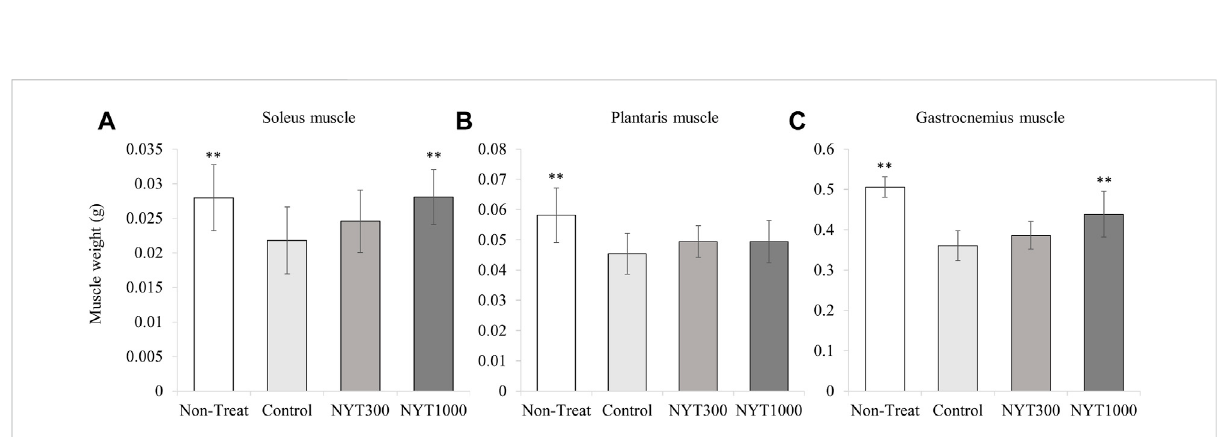
FIGURE 5 EffectofNYTonmuscleweight. (A) Soleusmuscle. (B) Plantarismuscle, (C) Gastrocnemius muscle(Numberoflegs;Eachgroup n =14).Values are expressed as means ± S.D. pp p < 0.01 vs. control group by dunnett test.